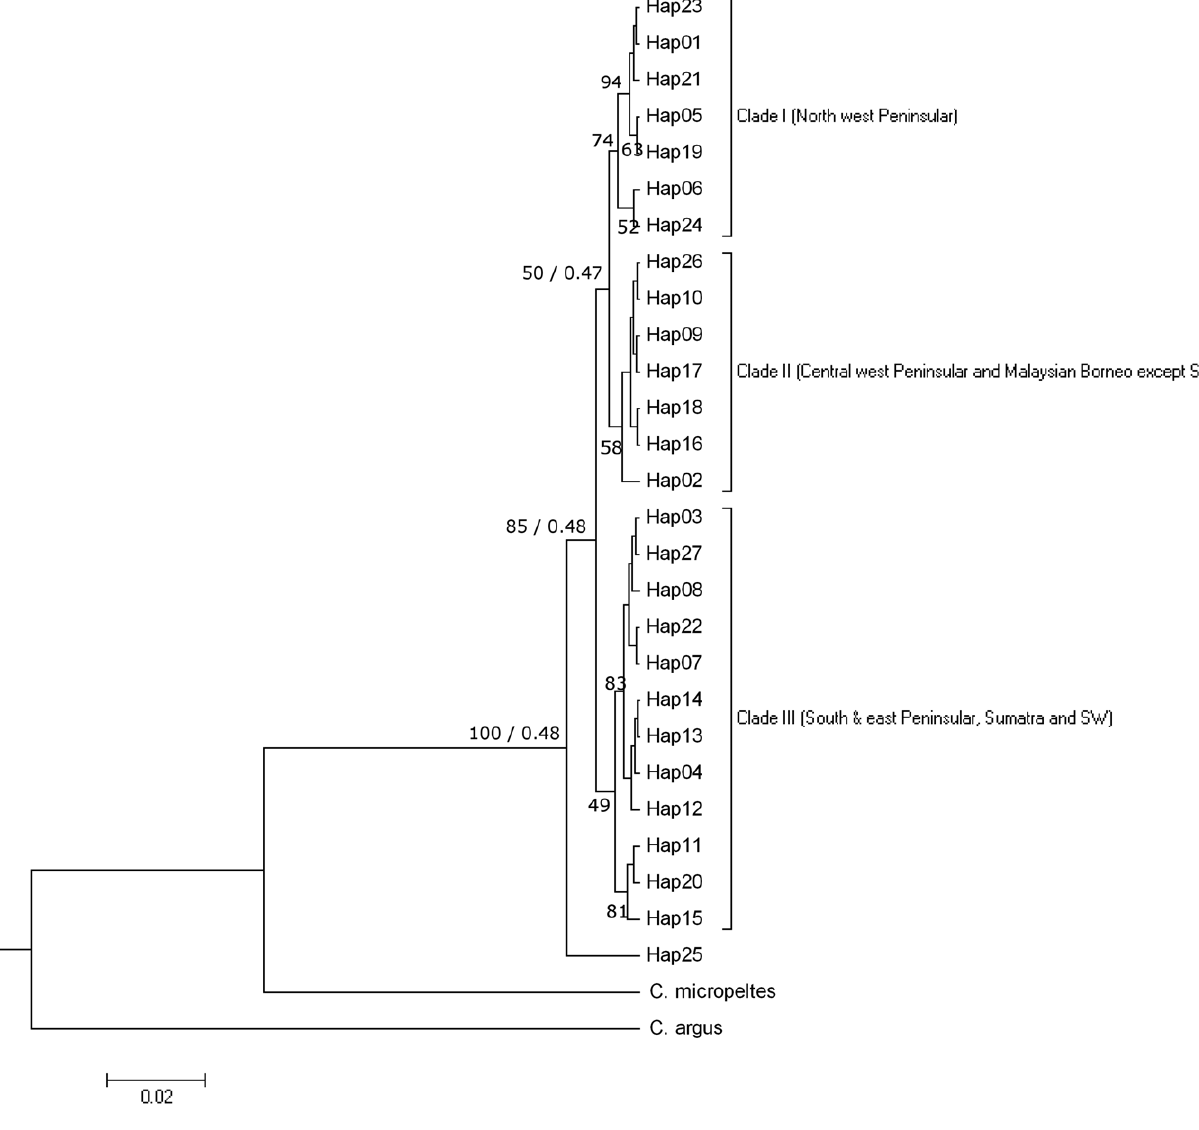
Figure 2. Bayesian clustering tree inferred from ND5 gene. Selected NJ bootstrap/Bayesian posterior probability values denoted at branch/ node for better visualization.